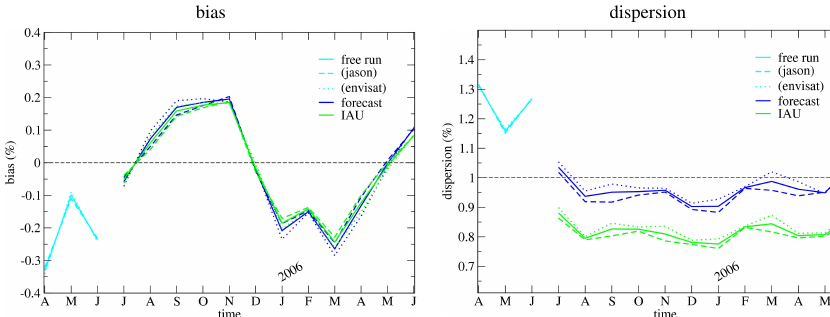
Figure 9. SSH bias (left panel) and dispersion (right panel) from RCRV.